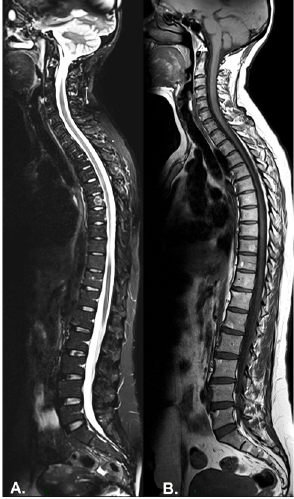
Figure 3. ( A ) Sagittal STIR, ( B ) T1-weighted sequence. Images show Romanus lesions as tiny subchondral bone marrow oedema (hyperintensities) in the antero-superior corners of lumbar vertebral bodies on STIR and, after the active phase, residual fatty transformation in the same regions on T1.